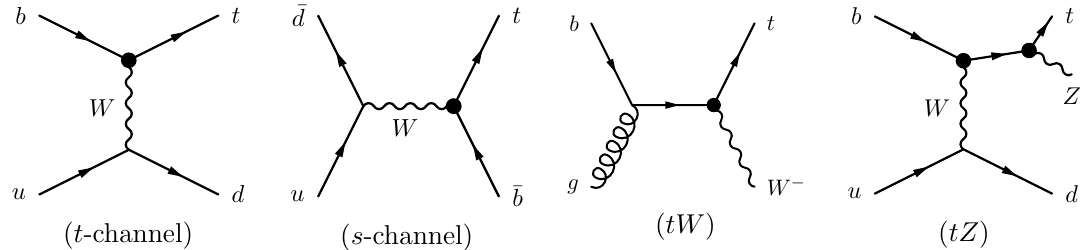
Figure 2 . Examples of Feynman diagrams contributing to single top production in SMEFT at leading order. The dots indicate possible operator insertions.